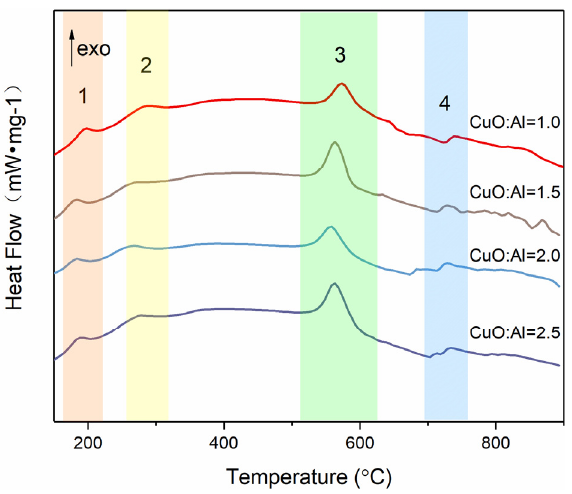
Figure 4. TEM images of ( a ) pure GO, ( b ) pure Al–CuO, ( c ) Al–CuO/GO with CuO:Al = 1.5:1, and ( d ) a partially enlarged image.